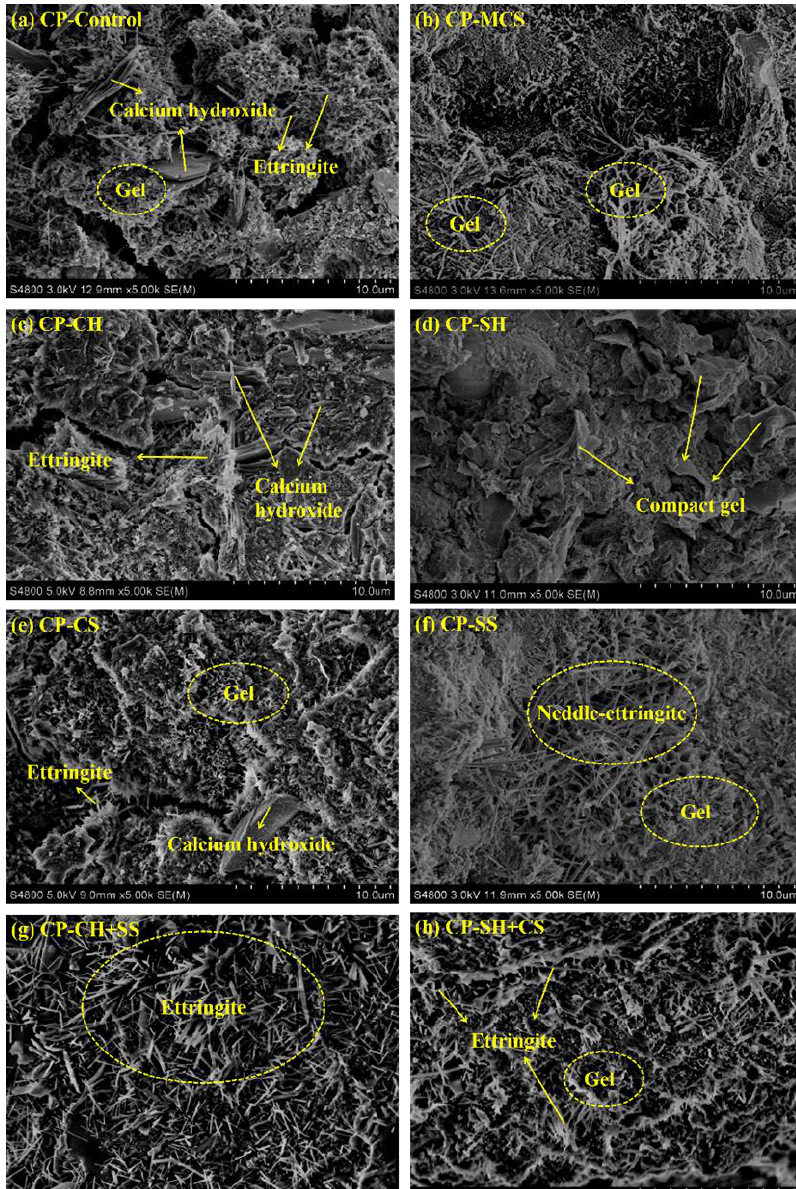
Figure 8. SEM images of cement pastes: ( a ) CP-Control, ( b ) CP-MCS, ( c ) CP-CH, ( d ) CP-SH, ( e ) CP-CS, ( f ) CP-SS, ( g ) CP-CH+SS, ( h )